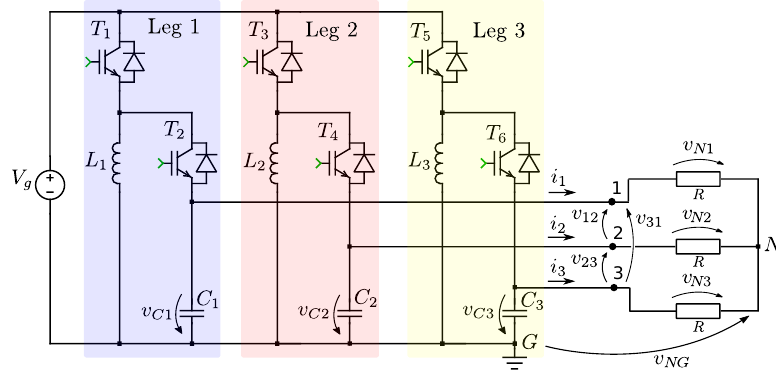
Figure 1. Three-phase Buck-Boost inverter